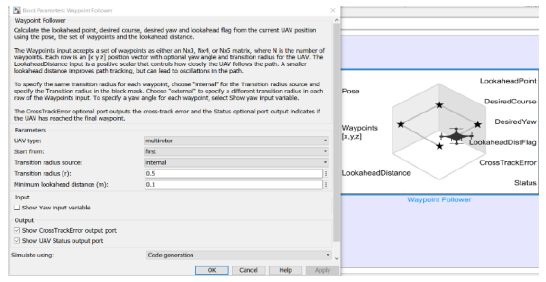
Figure 3. Parameters used in waypoint follower block